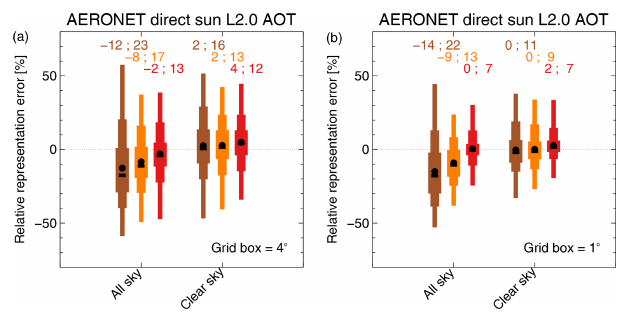
Figure 6. Yearly representation errors for AOT from AERONET di- rect sun L2.0 using all-sky or clear-sky conditions and model grid- box size of 4 ◦ (a) or 1 ◦ (b) . The colours indicate different collo- cation protocols: yearly (brown), daily (orange) and hourly (red). Numbers on top are the means of the errors and means of the sign- less errors. Table 6. Absolute representation errors for AERONET sites. Metric Figure 7. Yearly representation errors for AOT from AERONET